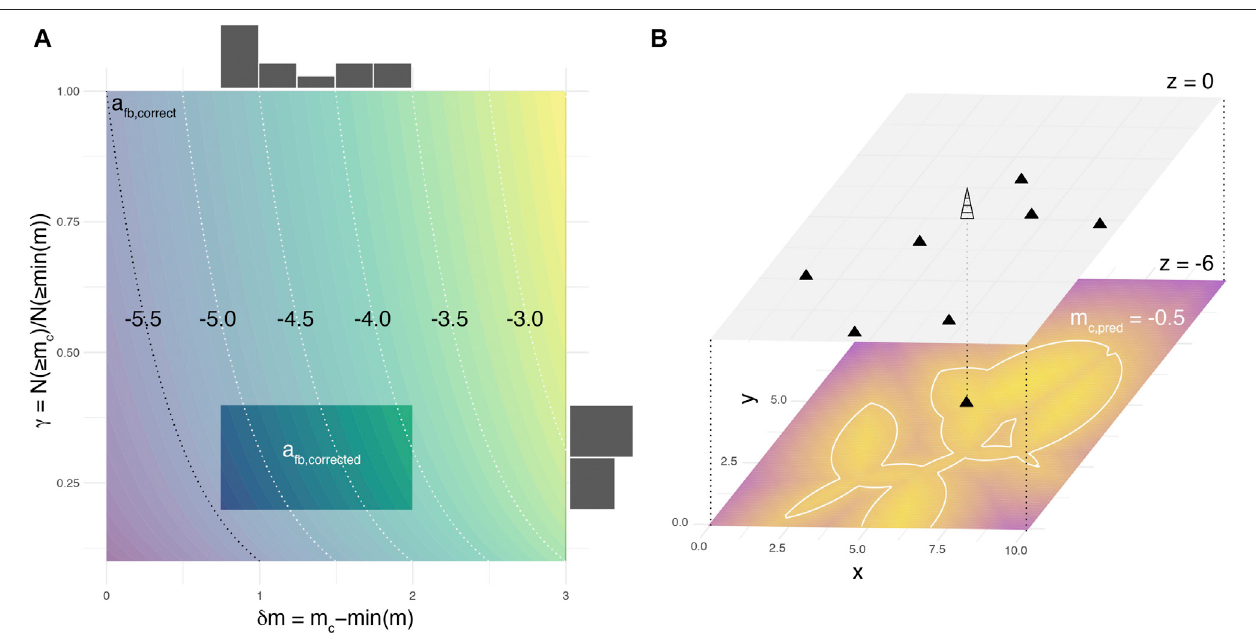
FIGURE 6 | Induced seismicity data mining potential from completeness analysis. (A) Estimating the underground feedback parameter a fb despite potential ambiguityontheminimummagnitudecutoffmentionedintheliterature,byusinginformationon δ m (cid:1) m c − min ( m ) and c (cid:1) N ( ≥ m c ) / N ( ≥ min ( m )) obtainedforthesites consideredinthepresentstudy(histograms) – a fb estimatesgivenfor b (cid:1) 1, N ( ≥ m ? ) (cid:1) 65and V (cid:1) 2 , 000 m 3 (1988Hijioricase) (B) Predictingthecompletenesslevelof a planned seismic network con fi guration using the prior model f prior ( d 3 ) of the BMC method (here with 8 stations, 7 randomly distributed at the surface and 1 located at the ad-hoc borehole with coordinates ( 5 , 5 , − 6 )